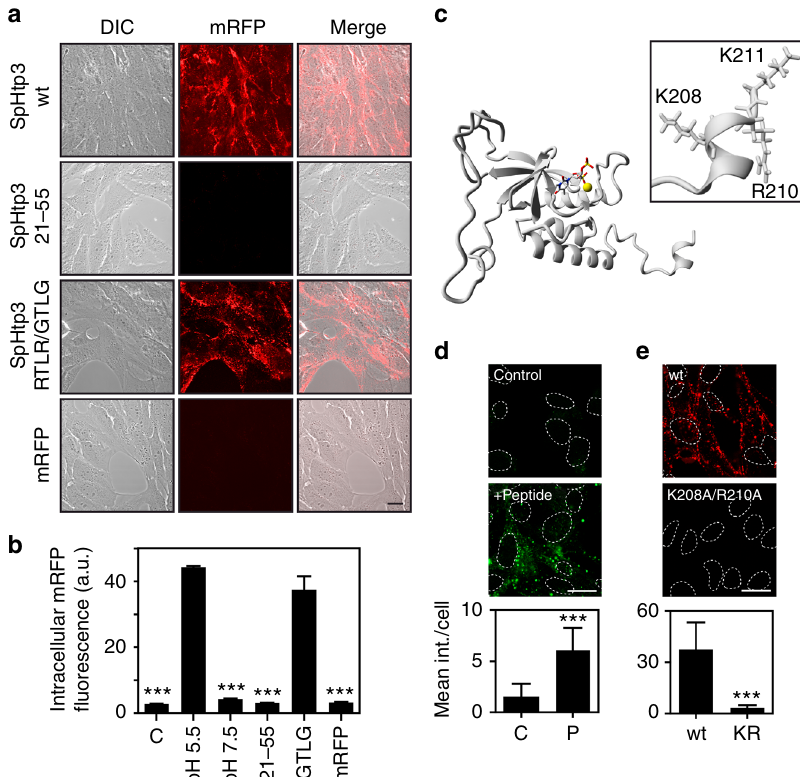
Fig. 3 SpHtp3 self-translocates into host cells via its C-terminus. a Self-translocation of SpHtp3-mRFP wt, SpHtp3-mRFP 21 – 55 (containing the RTLR sequence), a mutant of SpHtp3-mRFP RTLR/GTLG and mRFP only into living RTG-2 cells at pH 5.5. Scale bar: 20 µ m ( n = 3). b Quantitative FACS analysis of RTG-2 cells from Figs. 2d and 3a. Error bars denote s.e.m. ( n = 3). *** p < 0.001 (one way ANOVA). c Homology model of SpHtp3 calculated by YASARA containing the natural ligands (nucleotide analogue and Ca 2 + ion (yellow)). The inset shows the structural details of the very C-terminus of SpHtp3 containing a short charged helix built up by an YKARK sequence. d Self-translocation of a FITC-labelled C-terminal peptide of SpHtp3 (201 – 211 aa, P) into RTG-2 cells at pH 5.5. Nuclei are indicated by dashed lines. Error bars denote s.e.m. (cells: 50). *** p < 0.001 ( t -test). Scale bar: 20 µ m ( n = 3). e Self- translocation of a mutant of SpHtp3-mRFP (K208A/R210A, KR) in comparison to SpHtp3-mRFP wt into RTG-2 cells at pH 5.5. Nuclei are indicated by dashed lines. Error bars denote s.e.m. (cells: 50). *** p < 0.001 ( t -test). Scale bar: 20 µ m ( n =